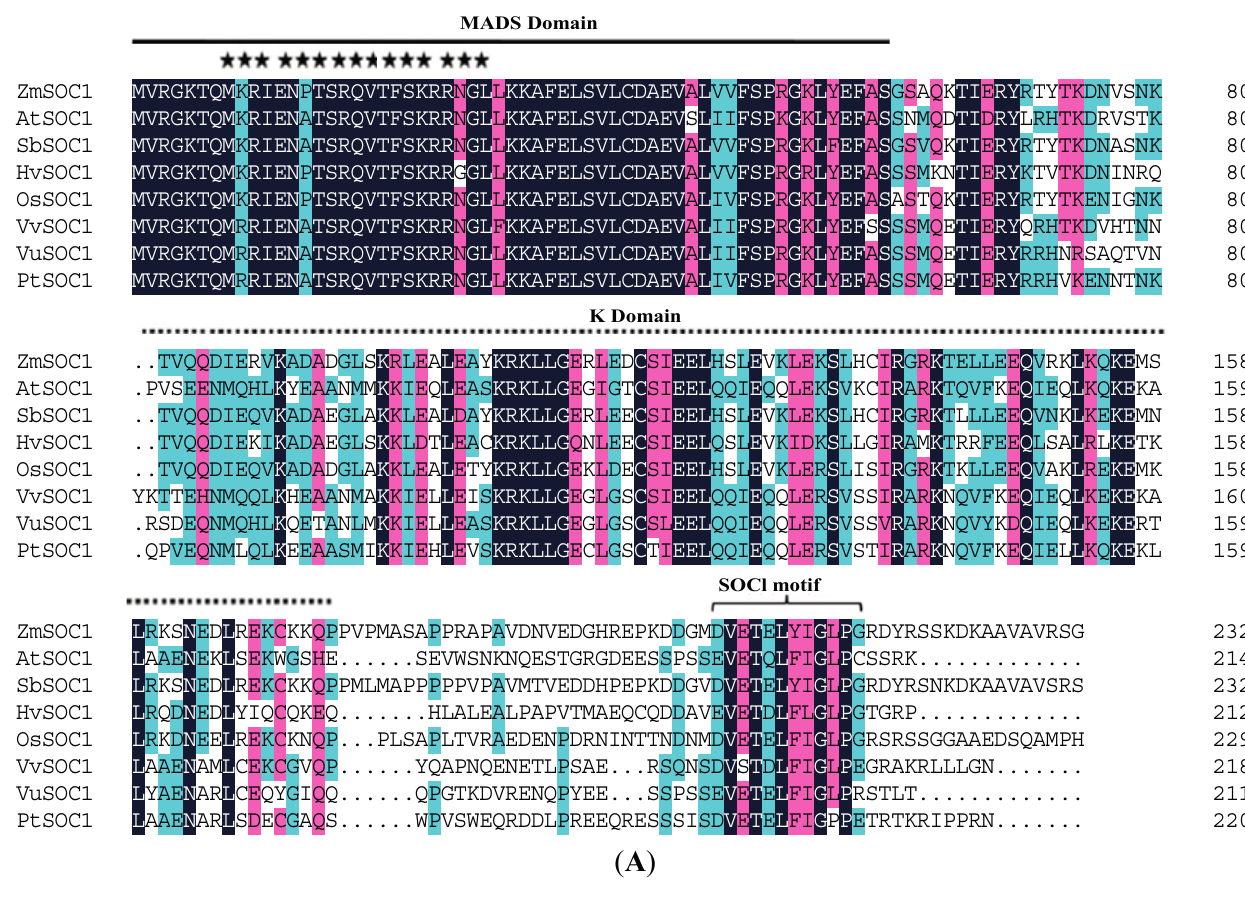
Figure 1. Bioinformatical analysis of ZmSOC1. ( A ) Amino acid sequence alignment of ZmSOC1 and its homologs from other plant species. The proteins were initially aligned using DNAMAN software. Identical and similar amino acids are shown in black and red shading, respectively. The MADS domain, K domain and SOC1 motif are marked with a solid line, dotted line and brackets, respectively. The locations of potential nuclear localization signals are marked with asterisks within the ZmSOC1 amino acid sequence; ( B ) Phylogenetic analysis of ZmSOC1 protein and its homologs from various plant species. The DNAMAN software was used for phylogenetic analysis. ZmSOC1 protein could be divided into dicot and monocot clades. The accession numbers of the SOC1 -like genes are as follows: Arabidopsis thaliana SOC1 : AtSOC1 ( NP_182090.1 ); Hordeum vulgare SOC1